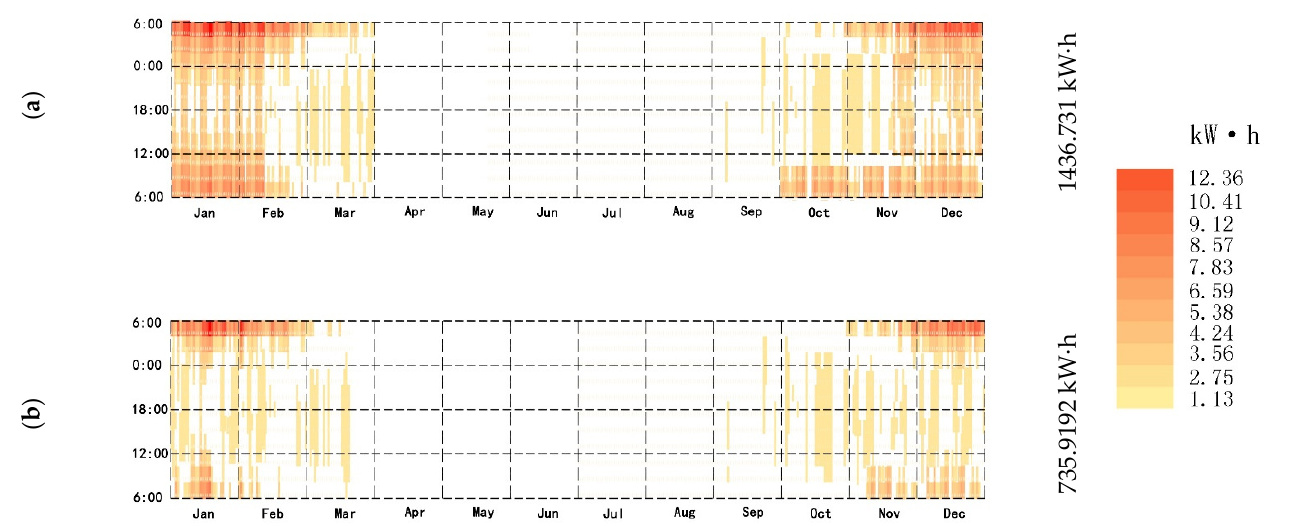
Figure 14. ( a ) Firewall–Sunlight system (with WSR). ( b )Firewall–Sunlight system (without WSR). 3.4. Suitable Year-Round Time for the Use of the Firewall–Sunlight System The presence or absence of WSR between the firewall and the additional sunlight room affects the temperature of the room after heating, the extension of heating time, the